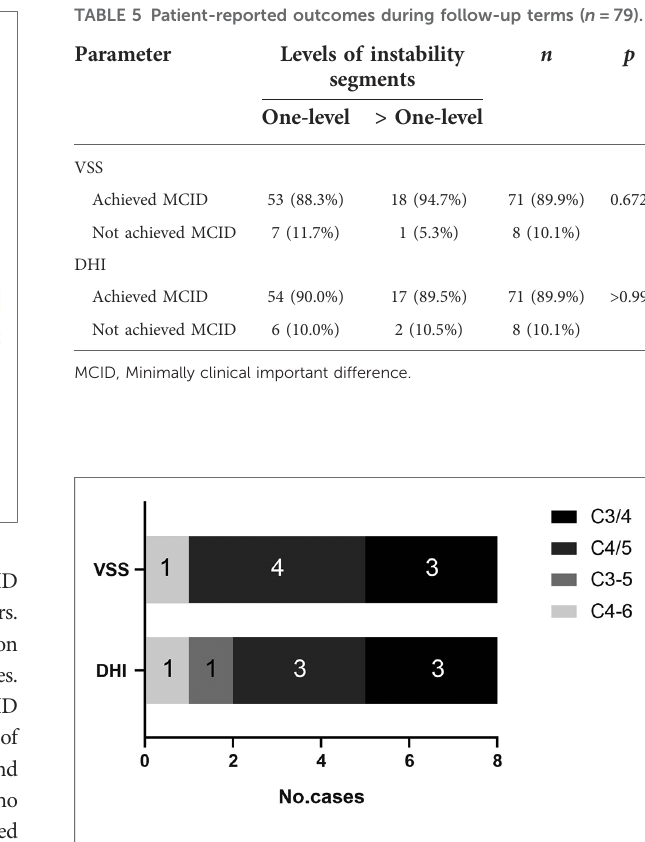
FIGURE 4 Distribution of levels of cervical spine failing to meet MCID assessed by VSS and